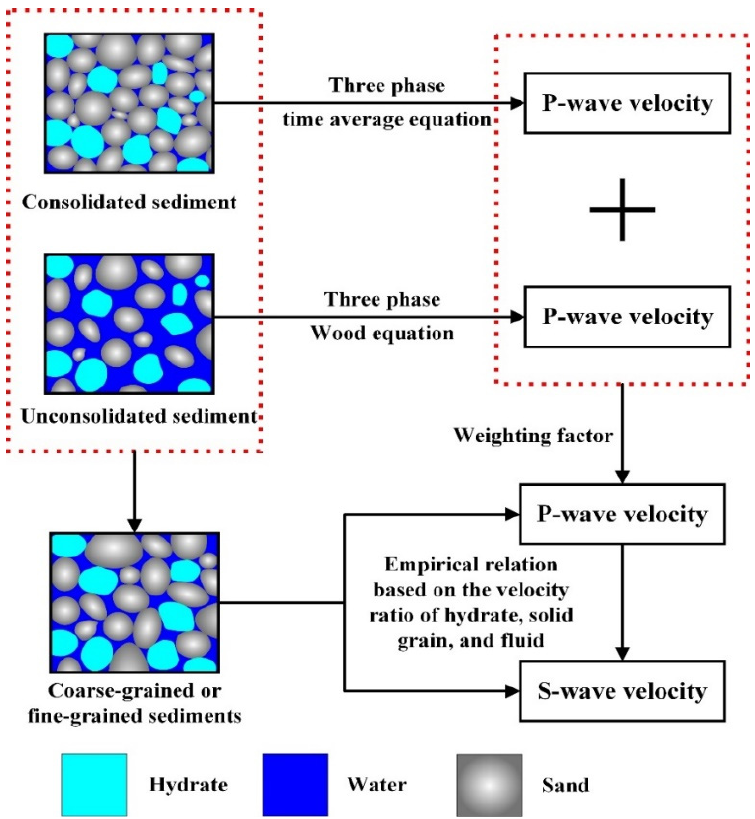
Figure 4. Workflow of the application of the three-phase weighted model.